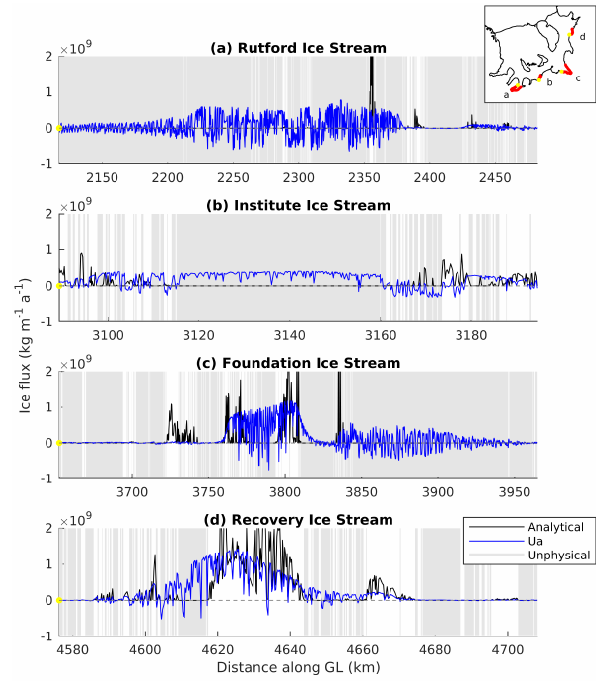
Figure 4. Comparison of fluxes calculated with Úa (blue) and analytical fluxes (black) along the grounding lines of four major ice streams draining into the Filchner–Ronne Ice Shelf. Locations where the flux formula provides unphysical results are marked in grey. Plotted grounding-line segments are located as displayed in the inset with western margins indicated by a yellow